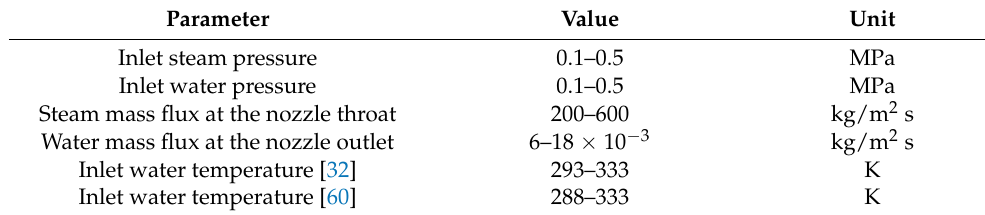
Table 14. The experimental conditions in [32,60].